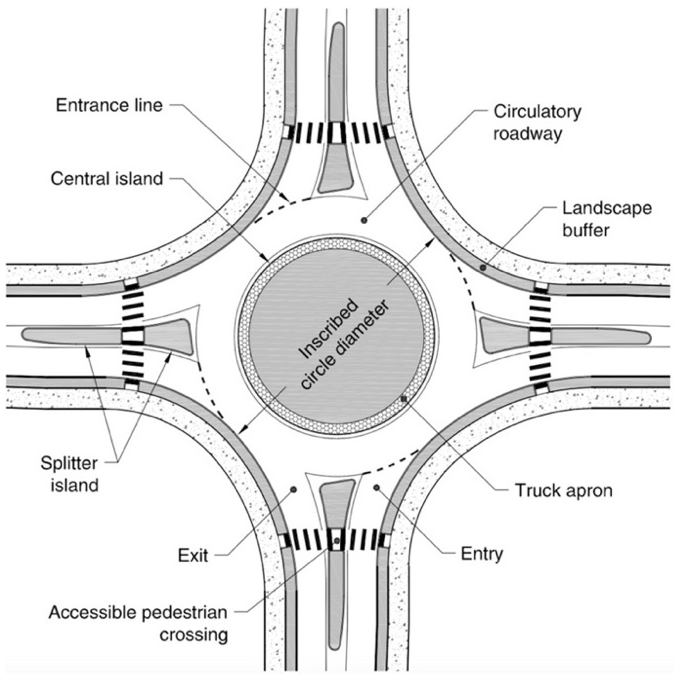
Figure 2. Roundabout Design Features [28].